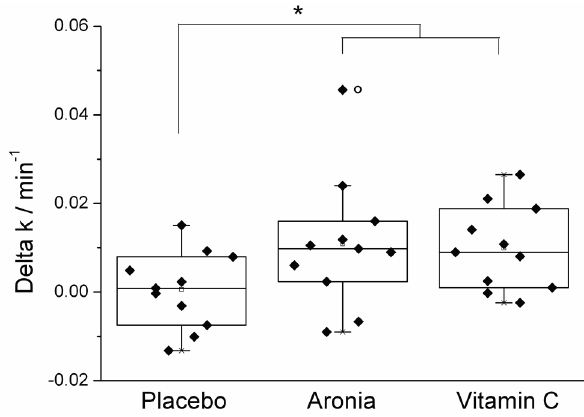
Figure 2. Rate constant after four week intake of verum and the placebo normalized to the initial values [55], * p <